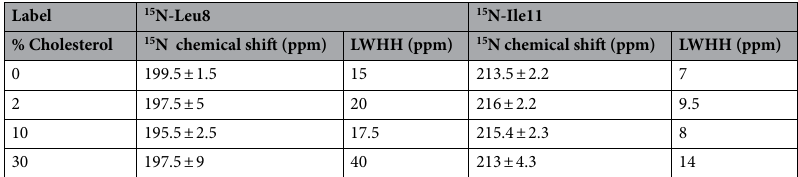
Table 3. 15 N chemical shift measurements of CRAC-TM_gp41 labelled with 15 N within the CRAC sequence, reconstituted into POPC lipid bilayers that were uniaxially oriented with the normal parallel to the magnetic field direction at peptide-to-lipid ratios of 2 mol% in the presence or absence of cholesterol. The errors in determining the chemical shift were derived from the spectral resolution, the line width and the signal-to- noise ratio. LWHH line width at half height.